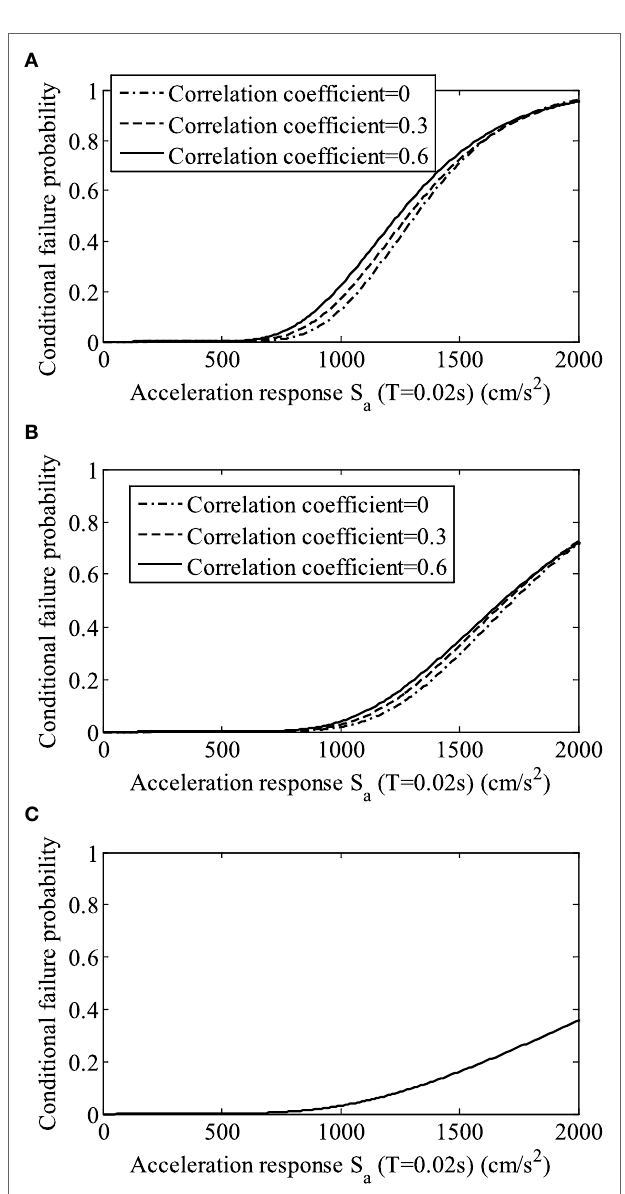
FIGURE 7 | Seismic fragility curves for occurrence of accident with serious consequences . (A) Case 0, (B) Case S, and (C) Case T.